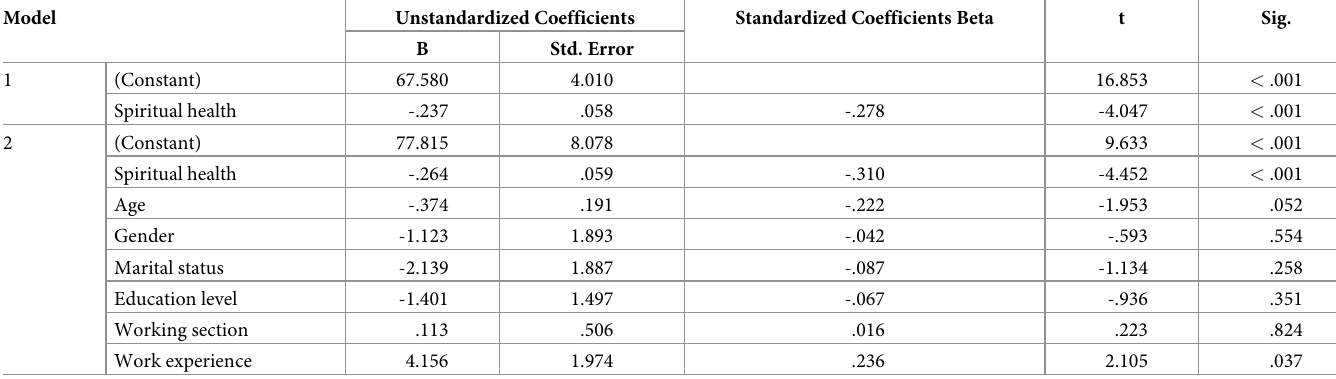
Table 4. Associated factors of aggression based on spirituality and socio-demographics.